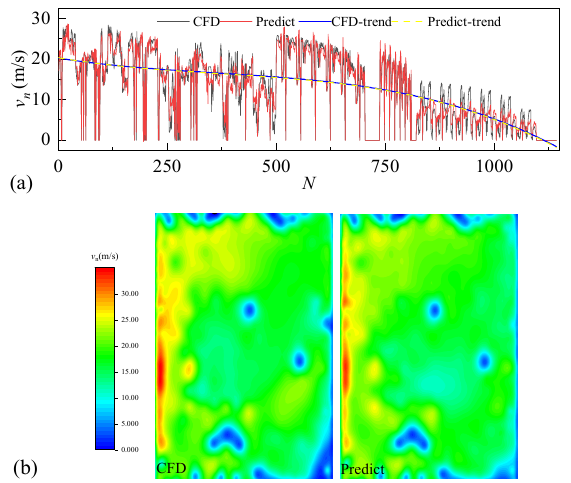
Figure 23. The prediction results of the normal velocity of the exit section of the volute: ( a ) the change of the normal velocity with the grid; ( b ) the comparison of the normal velocity contour.